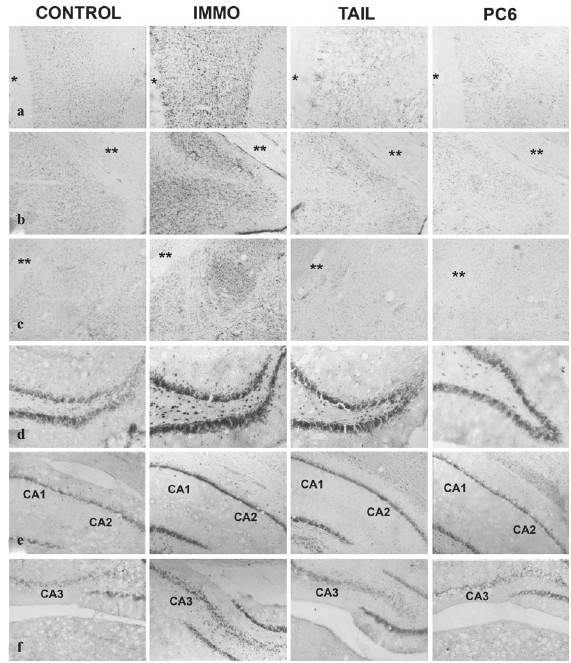
Figure 2 - Photomicrographs of coronal sections of rat brain regions with significant increases in Fos immunoreactive cells (dark spots) in rats submitted to immobilization stress (IMMO) as compared to control non-stressed rats (control) and the absence of activation in rats submitted to immobilization stress plus electroacunpucture in the tail or PC6. (a) prefrontal cortex, (b) medial amygdala, (c) central amygdala, (d) dentate gyrus, (e) CA1 and CA2, (f) CA3. *indicates the longitudinal brain fissure and **indicates the optic tract. Magnification, 200X.